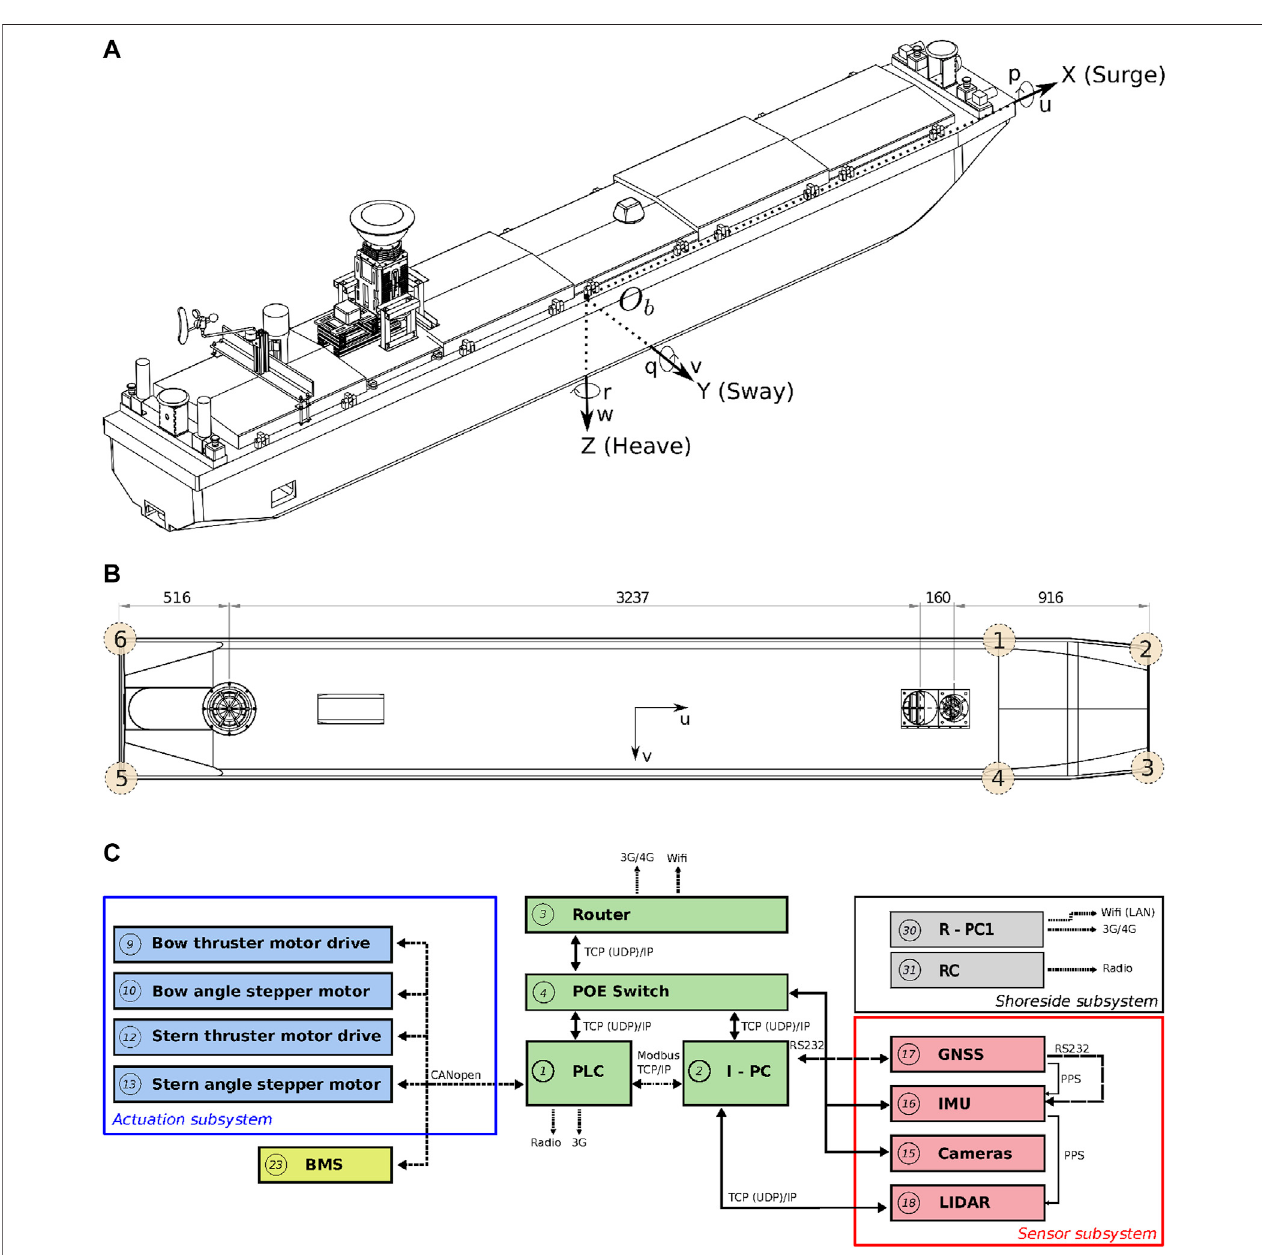
FIGURE1| Geometryofthe Cogge : (A) fullgeometryandreferenceframes, (B) bottomviewofthehullwithlongitudinaldimensions,and (C) maincomponentsand communication links (as a single vessel). Panel (A) and (B) were modi fi ed from Peeters et al., (2020c), and (C) reproduced from Peeters et al., (2020d).